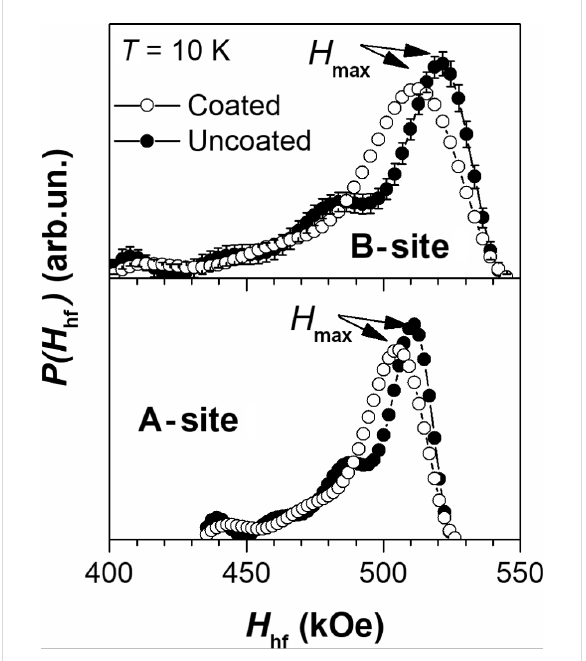
Figure 7: Distribution of the magnetic field H hf values obtained from the Mössbauer spectra for uncoated and HSA-coated magnetic nano-